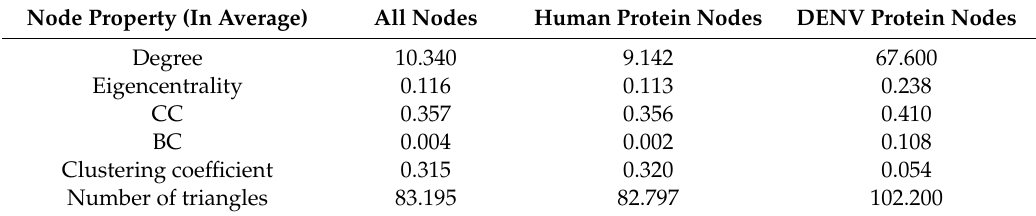
Table 3. Node properties for human protein nodes and DENV protein nodes.